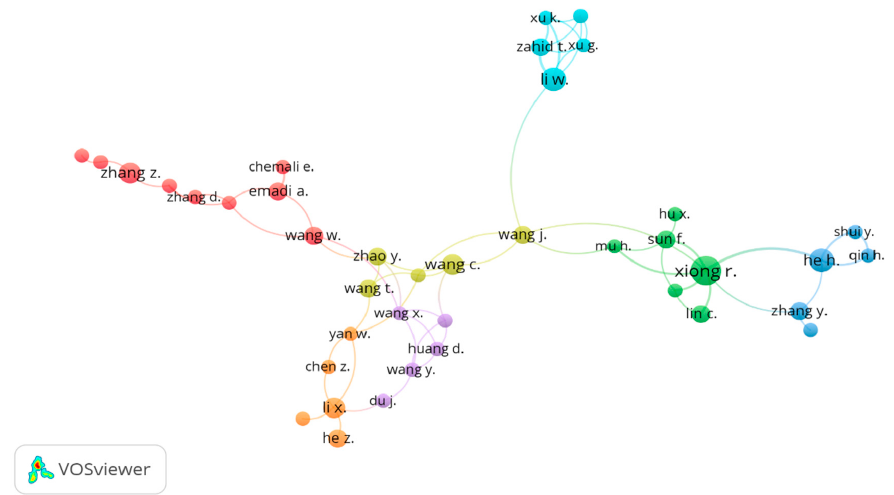
Figure 18. Cluster of co-authorship and author in the SCOPUS DB.